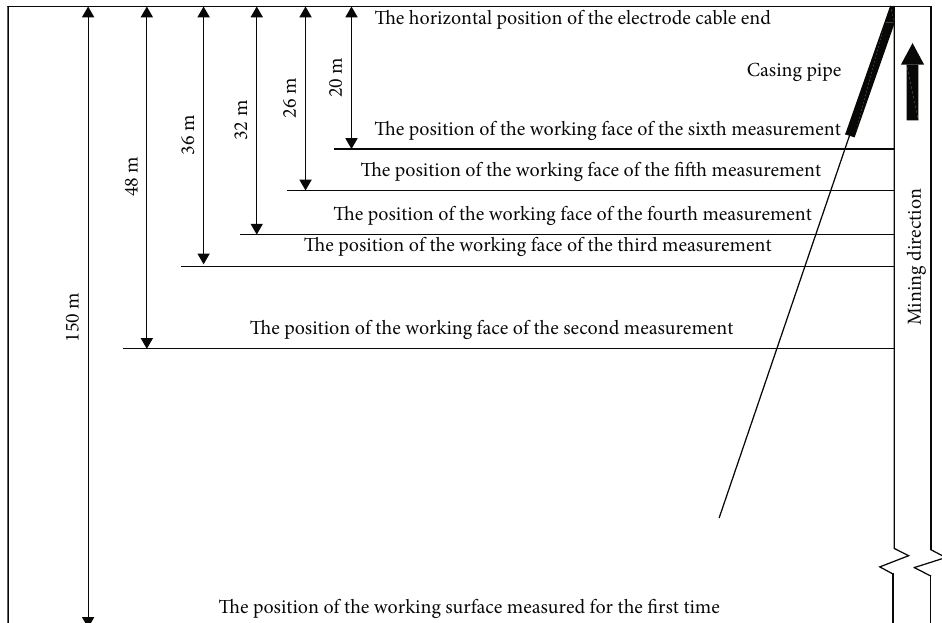
Figure 16: The relationship between the borehole apparent resistivity and the